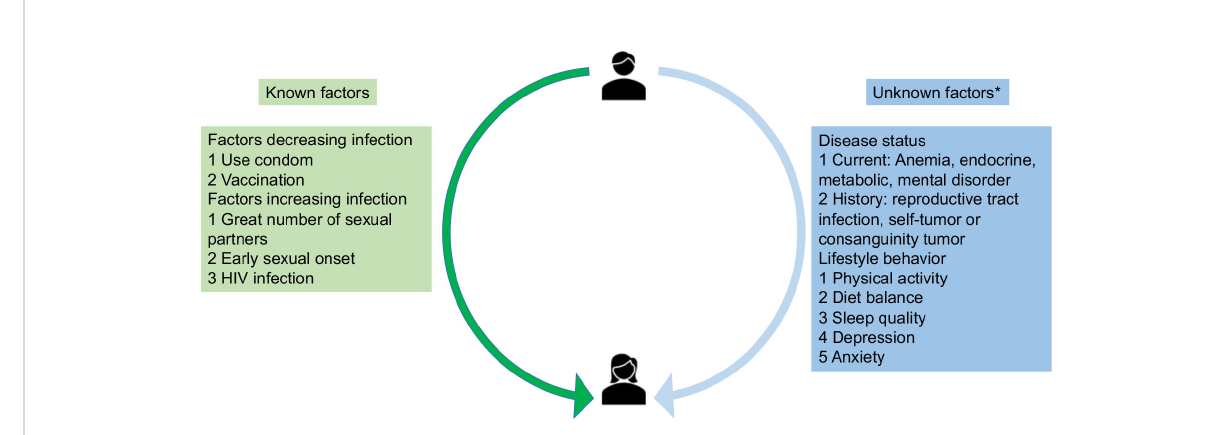
FIGURE 2 Transmission cycle from male to female and known/unknown factors in fl uencing transmission dynamics HIV, human immunode fi ciency virus. *Risk factors for the association direction was unclear before the study in this fi